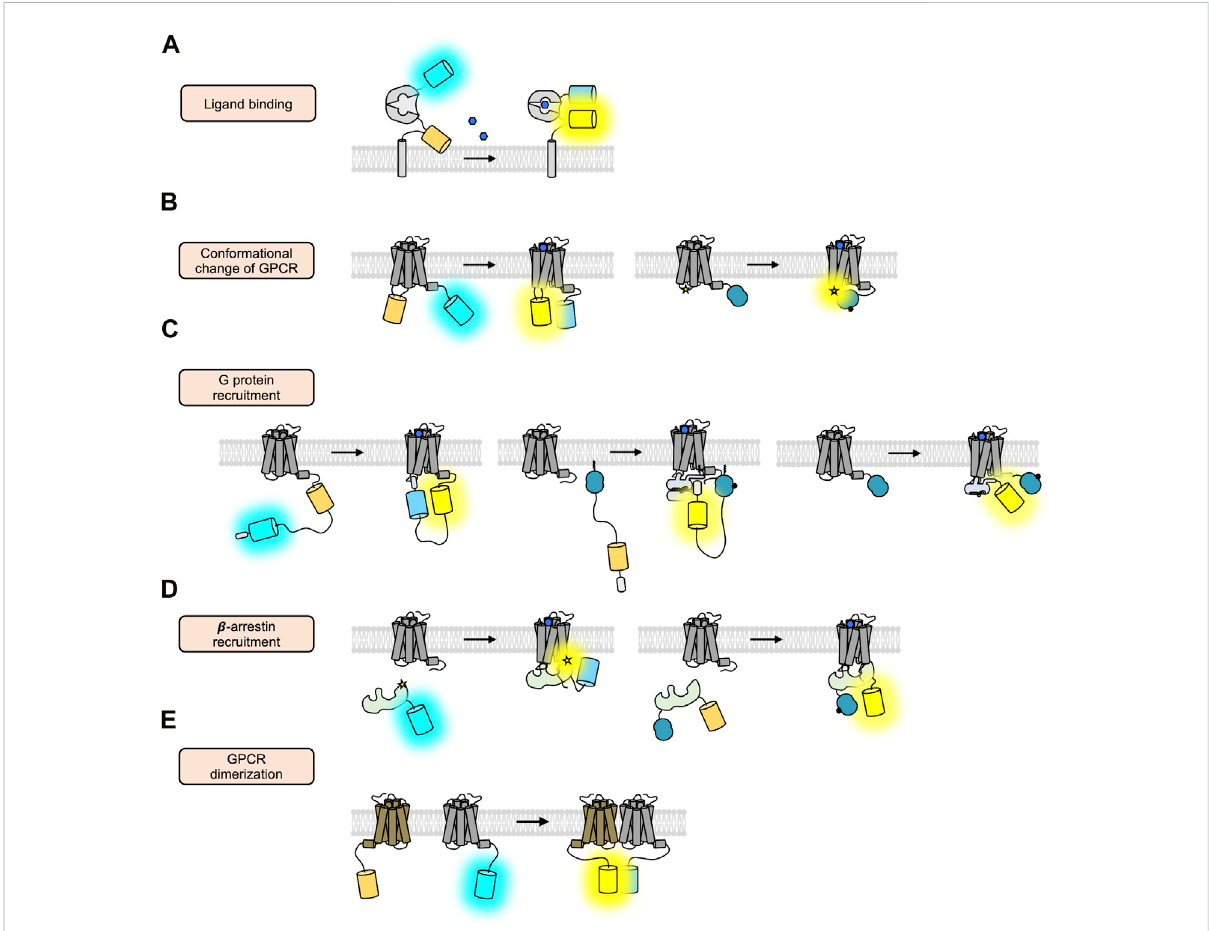
FIGURE 2 FRET/BRET-based GPCR biosensors. (A) Schematic design of the ligand-sensing biosensors based on FRET (Tsien, 2006). The FRET signal between cyan and yellow FP inserted inthe N- and C-terminus ofthe ligand-sensing domain isincreased upon ligand binding. (B) Schematic design of the FRET/BRET-based biosensors detecting the conformational change of GPCRs (Grif fi n et al., 1998; Vilardaga et al., 2005). In the right panel, a bluecirclerepresentsaluciferaseandastardisplaysFlAsH. (C) SchematicdesignoftheFRET/BRET-basedbiosensorsdetectingtherecruitment of G proteins (Malik et al., 2013; Wan et al., 2018; Maziarz et al., 2020). (D) Schematic design of the FRET/BRET-based biosensors detecting the recruitment of β -arrestin (Charest et al., 2005; Nuber et al., 2016). (E) Schematic design of the FRET-based biosensors detecting the dimerization of GPCRs (Lukasiewicz et al.,